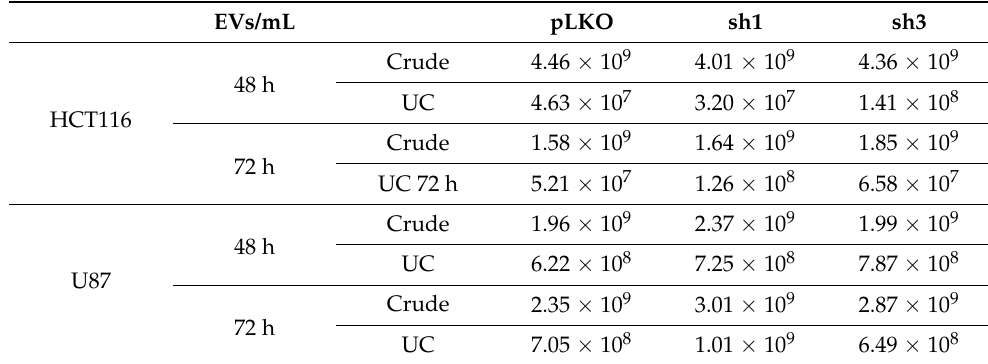
Table 1. EVs NTA-estimated concentration for each condition in each cell line according to the different culture times (UC: Ultracentrifugation).